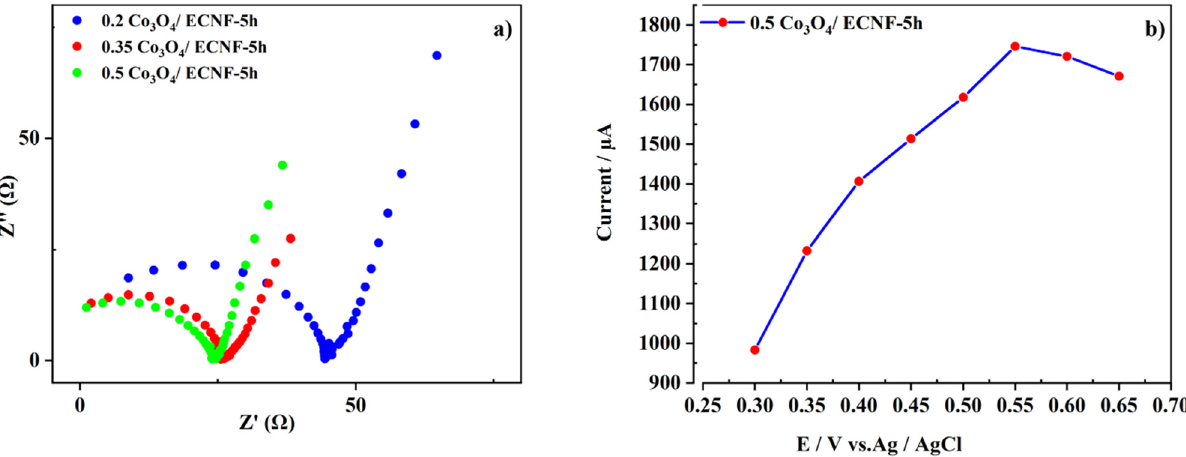
Figure 6: ( a ) EIS patterns of Co 3 O 4 /ECNF nanocomposites, and ( b ) e ff ects of applied potential on the amperometric response of the 0.5 Co 3 O 4 /ECNF - 5h electrode in 0.1 M NaOH solution containing 4.0 mM